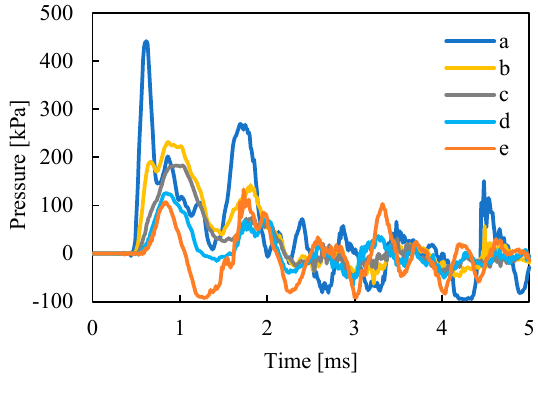
Figure 9. Brain pressure responses at five locations in the